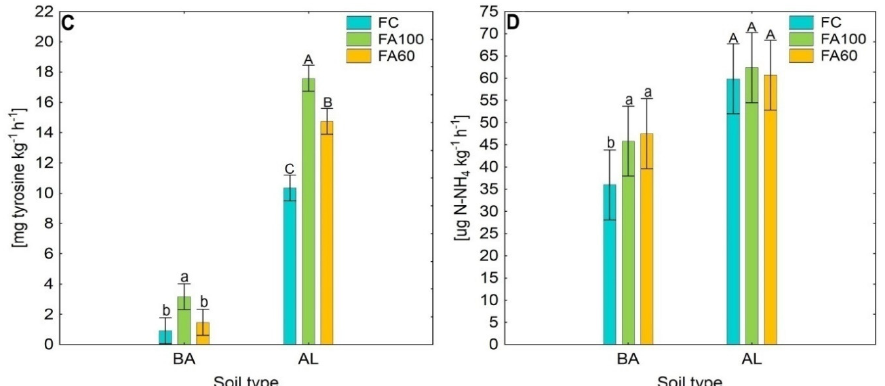
Figure 1. Changes in enzymes activity in soil as influenced by the application of phosphorus mineral fertilizer at an optimal dose (FC), at an optimal dose enriched with beneficial bacterial strains (FA100) and at a 40% reduced dose enriched with beneficial bacterial strains (FA60). ( A )—the activity of β -glucosidase, ( B )—the activity of acid phosphomonoesterase, ( C )—the activity of protease, ( D )—the activity of urease. Vertical bars denote 0.95 confidence intervals. Different letters indicate significant differences ( p < 0.05). The significant differences were calculated separately for each soil type by post hoc Tukey tests after F-Welch test for β -glucosidase ( A ) and after ANOVA for the other enzymes ( B — D ). Different lowercase letters indicate significant differences within BA while uppercase letters within AL soil type. Explanation: BA—Brunic Arenosol, AL—Abruptic Luvisol, PNP— p -nitrophenol.